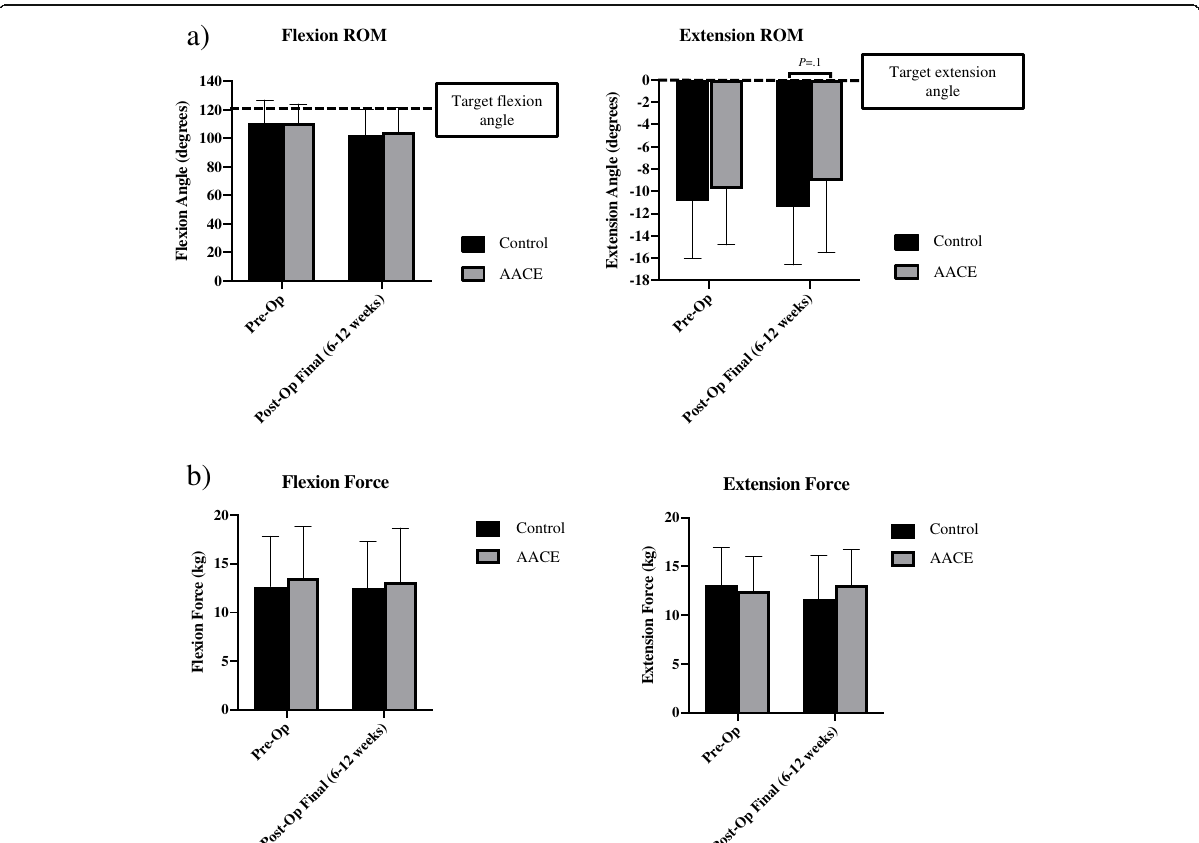
Fig. 2 Measured Knee Function. A ) Goniometric range of motion (ROM) pre-op and post-op measures for knee flexion and extension in the control and active assisted cycle ergometer (AACE) groups. n = 25 – 26 per group. B ) Resisted isometric knee flexor and extensor strength using a Lafayette Manual Muscle Tester pre-op and post-op measures for the control and active assisted cycle ergometer (AACE) groups. n = 24 – 26 per